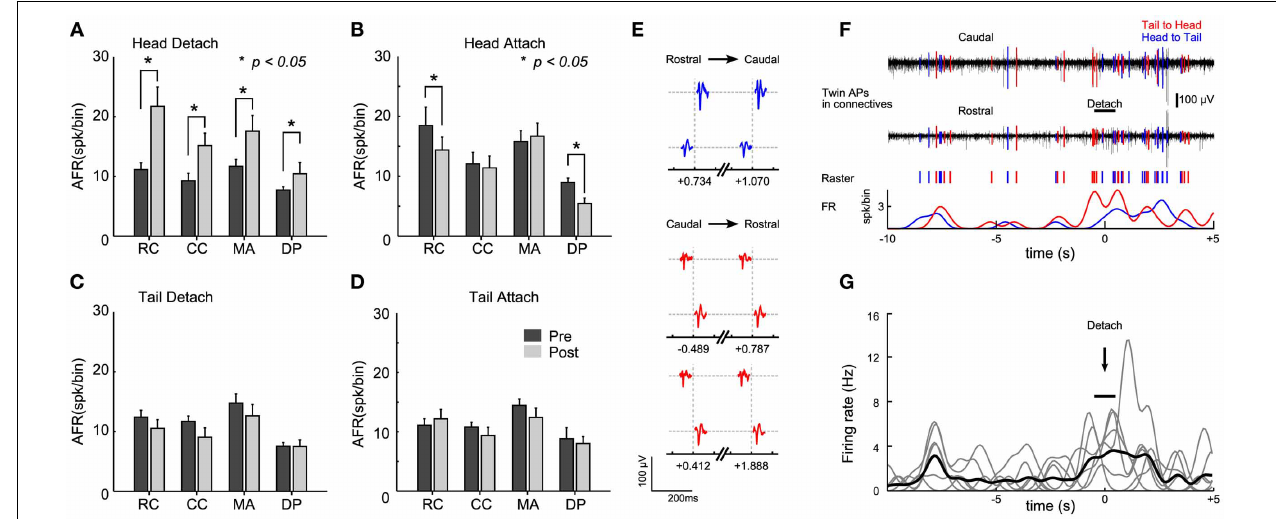
FIGURE 4 | Identification of electrical patterns underlying head sucker detachment. (A) Averaged < AFR j > over 30s before (black bars) and after (gray bars) head sucker detachment. AFRs obtained from 12 semi-intact leeches in which the electrical activity of the rostral connective (RC), caudal connective (CC), medial anterior nerve (MA), and dorsal posterior nerve (DP) were recorded. (B–D) As in (A) but for the head attachment, tail detachment, and tail attachment, respectively. (E) . Twin APs identified from connective recordings during the head detachment shown in (F) . Three pairs of APs with a constant delay ∼ 6ms were identified. Twin APs in blue correspond to APs traveling from head to tail (and in red for those traveling from tail to head). The number below each twin indicates the occurrence time between the